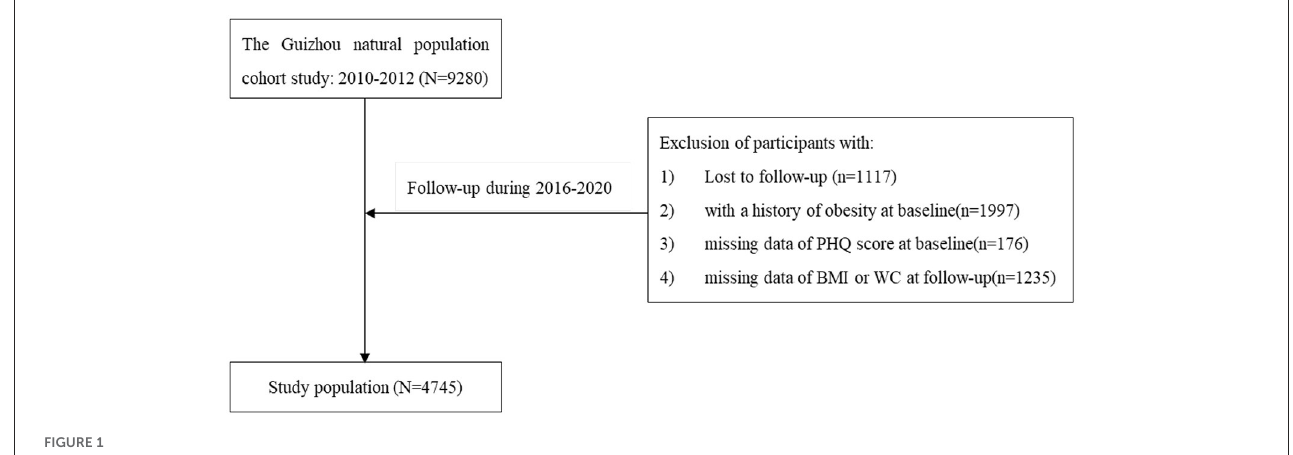
FIGURE1 The flow